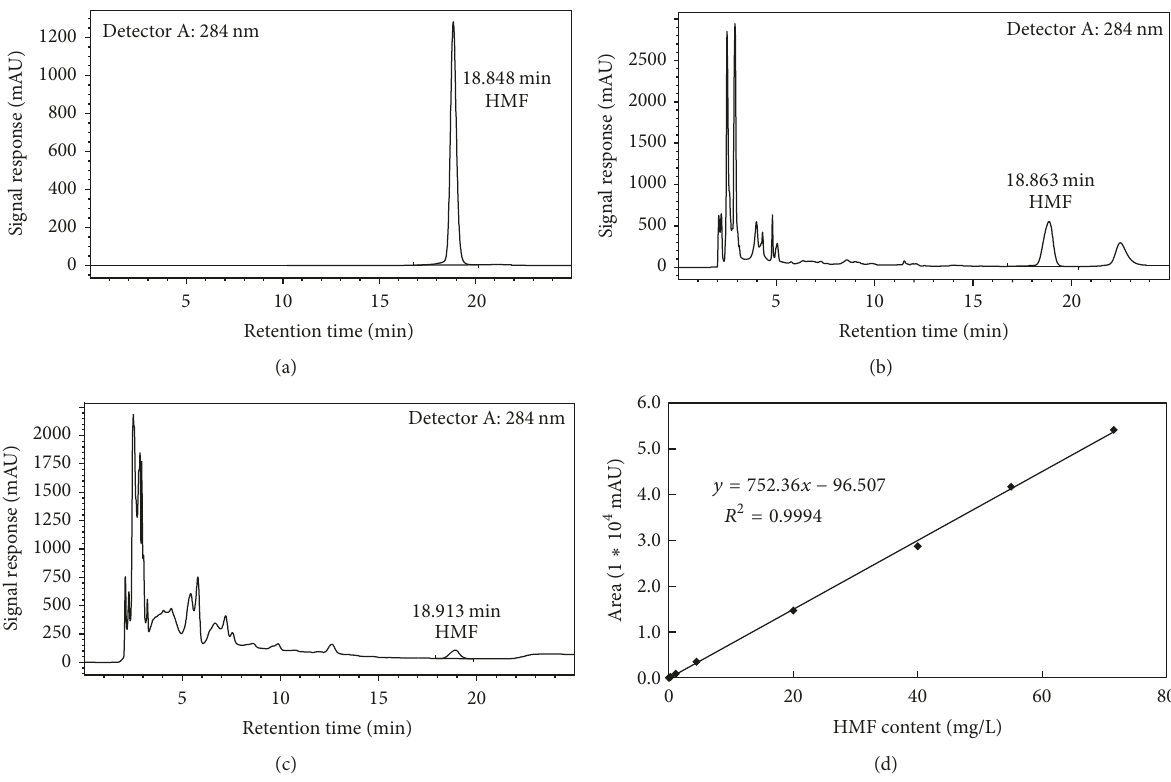
Figure 1: (a) A representative standard solution. (b) A representative vinegar sample. (c) A representative soy sauce sample; standard 5- hydroxymethylfurfural (HMF) (d) determined by high-performance liquid chromatography (HPLC) spectrograms (284